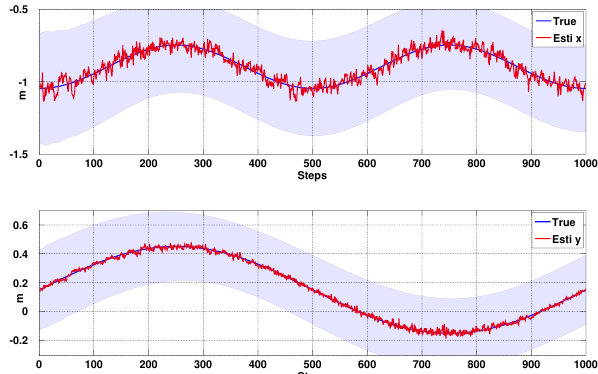
Figure 8. Simulation results for Position Based Visual Servoing (PBVS) tracking: position estimation. W ˆ x and W ˆ y with 3 σ confidence boundary.